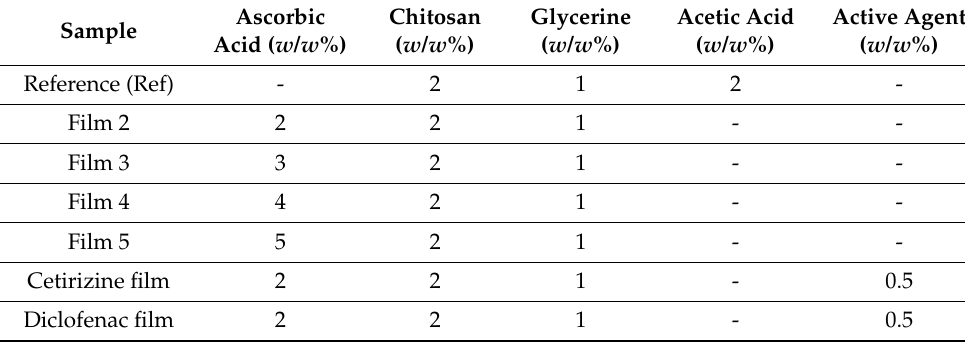
Table 1. The composition of the solutions for film